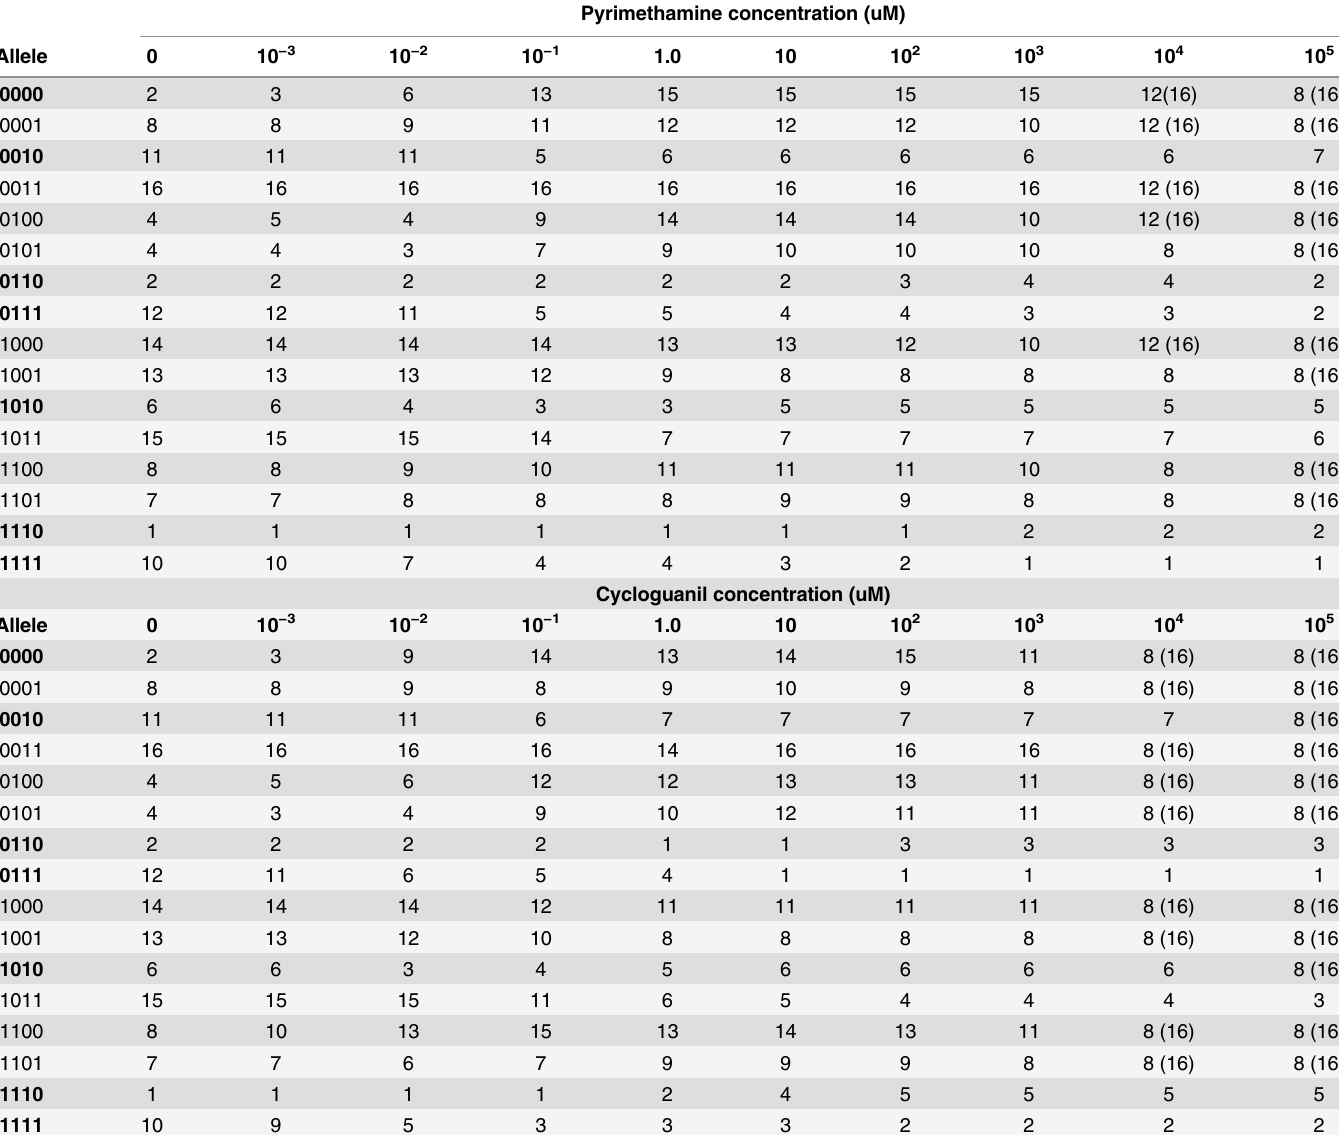
Table 1. The rank order of fitnesses changes as a function of drug concentration. Here we observe how the rank order of the fitnesses of alleles across the landscape changes as a function of drug environment. This dynamic order implies that the probability of individual trajectories must also change as a func- tion of drug. Alleles that are in bold correspond to those that have been consistently observed in field isolates of P . falciparum (See Supporting Information for more references). Also note differences between the rank order patterns of PYR and CYC. Columns with a 16 in parentheses indicate that the allele is actually tied for the lowest ranking of all alleles in the set for that